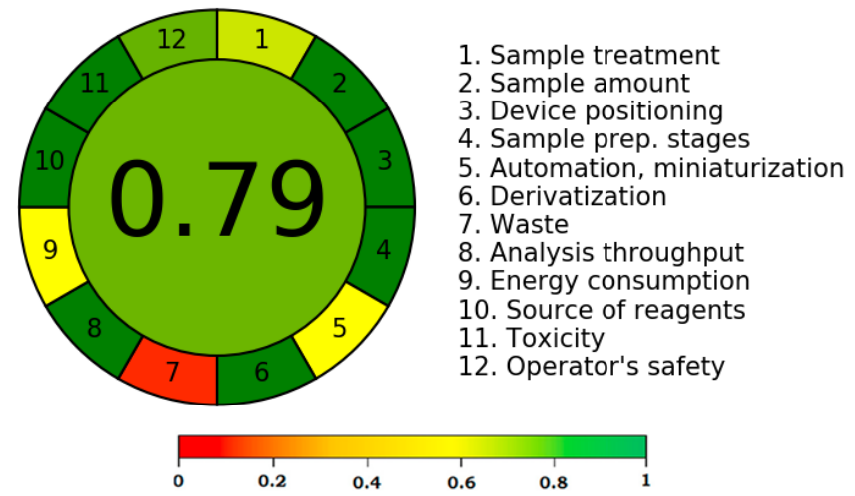
Figure 5. “Analytical GREEnness (AGREE)” score for the greener HPTLC -UV method.